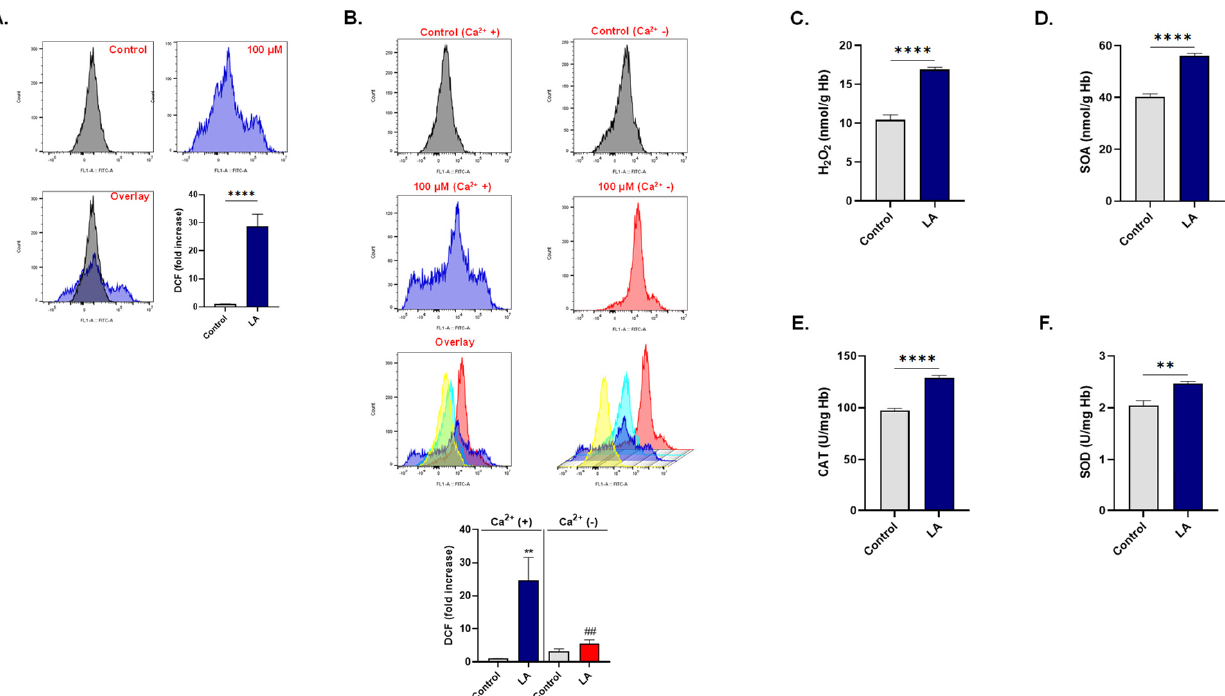
Figure 5. LA triggers Ca 2+ -dependent oxidative stress. ( A ) Representative histograms and fold increase in MFI of DCF fluorescence of cells exposed to 0–100 µ M of LA. ( B ) Representative histograms and fold increase in MFI of DCF fluorescence of cells exposed to 0 or 100 µ M of LA in presence or absence of Ca 2+ . ( C ) Intracellular content of H 2 O 2 in cells treated with 0 or 100 µ M of LA. ( D ) Intracellular content of SOA in cells treated with 0 or 100 µ M of LA. (E) CAT activity in cells treated with 0 or 100 µ M of LA. ( F ) SOD activity in cells treated with 0 or 100 µ M of LA. ** ( p < 0.01) and **** ( p < 0.0001) indicate significantly different values from control conditions whereas ## ( p < 0.01) indicates statistical significance compared to LA-treated